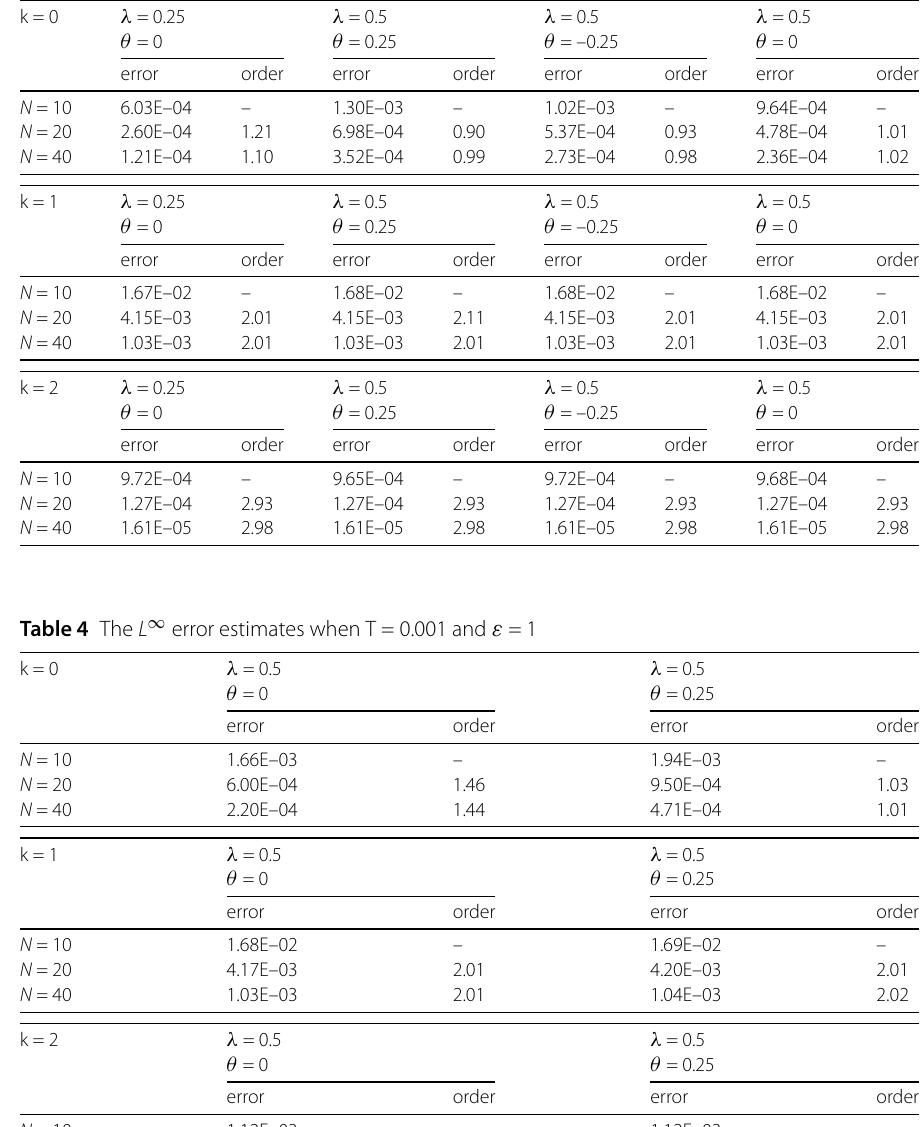
Table 3 The L ∞ error estimates at T = 0.001